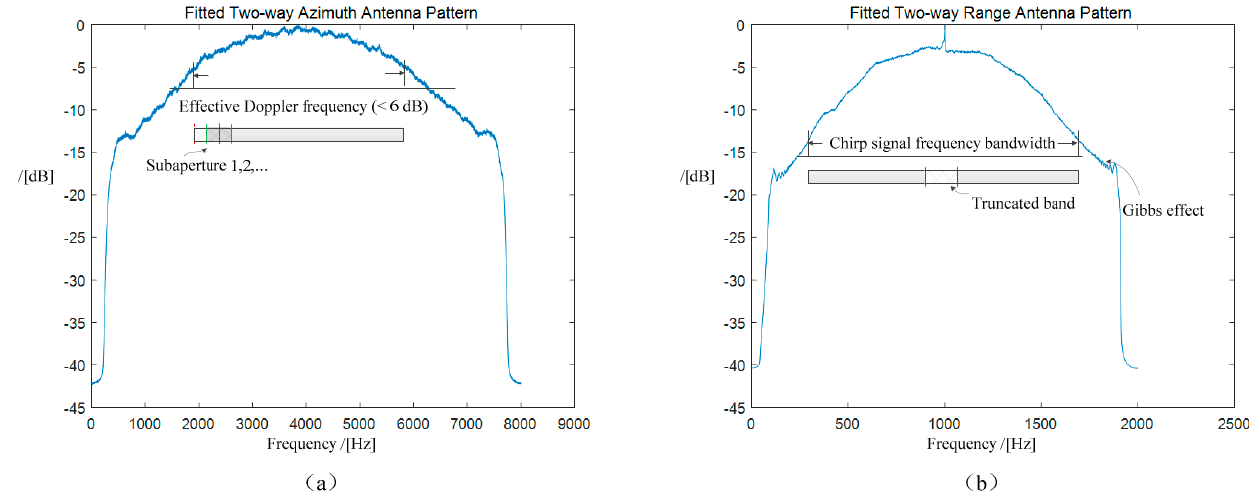
Table 2. Frequency allocation configurations and filter parameter settings.